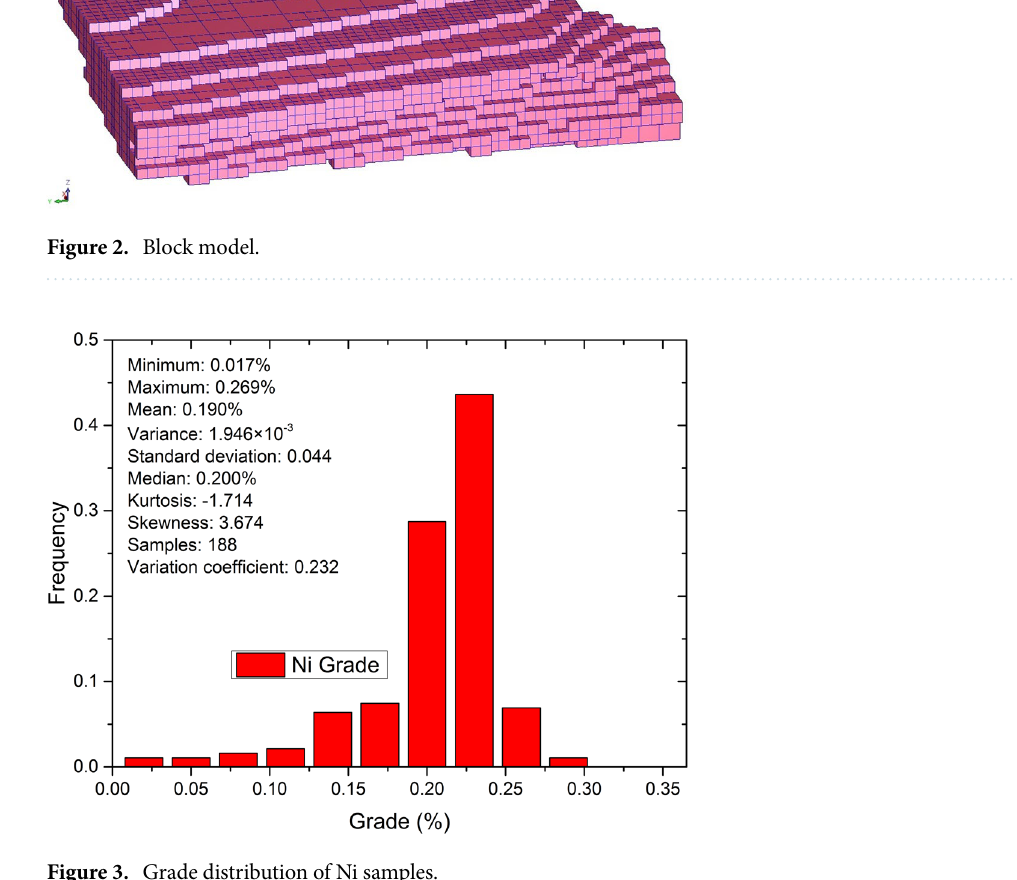
Figure 3. Grade distribution of Ni